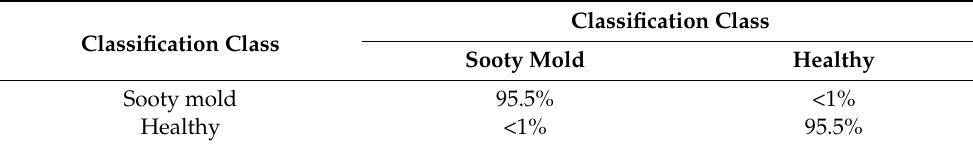
Table 5. Confusion matrix of sooty mold vs. healthy mango leaves.